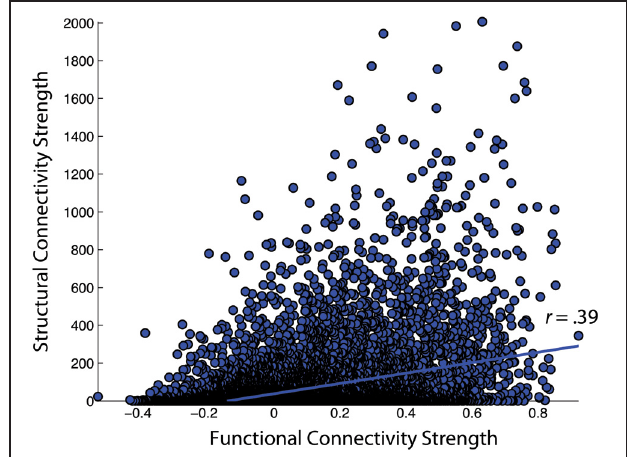
FIGURE 6 | Correlation of functional and structural connectivity strengths for the group-average 188 × 188 connectivity